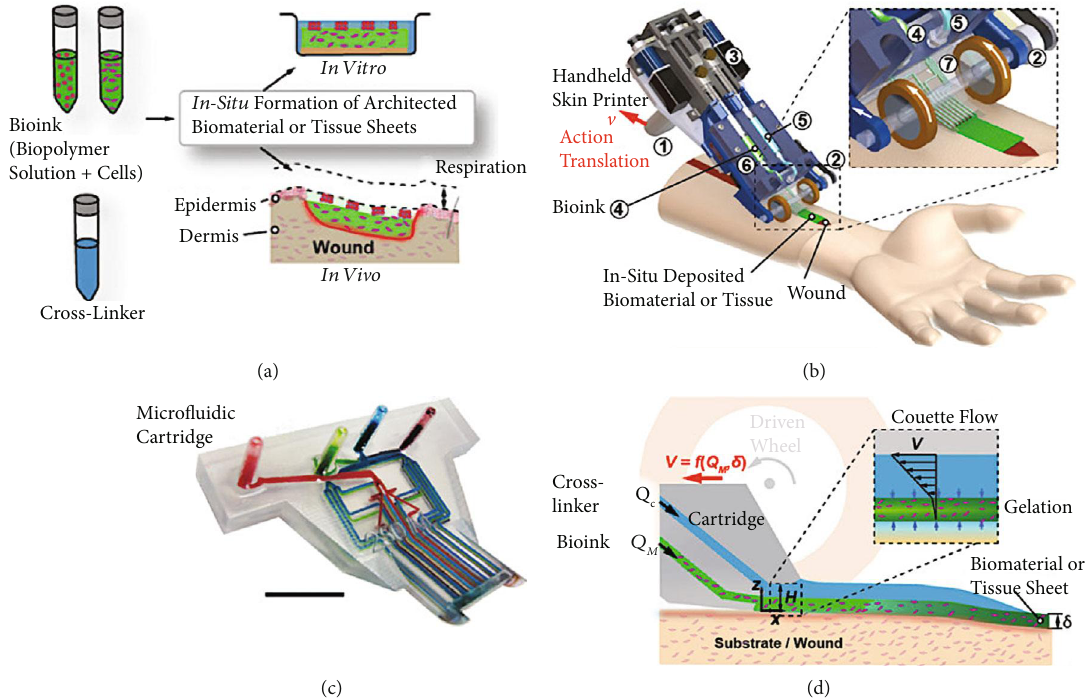
Figure 25: Handheld skin printer: (a) schematic diagram illustrating working principle of handheld bioprinter. (b) Rendered image of handheld bioprinter. (c) Photograph of 3D printed micro fl uidic cartridge. Scale bar 10 mm. (d) Schematic sideview image showing sheet formation between moving micro fl uidic cartridge and deposition surface or wound. Inset indicates fl uid velocity pro fi les in bioink (green) and cross-linker layers (blue). Reproduced (or adapted) with permission [122], ©2018, Royal Society of